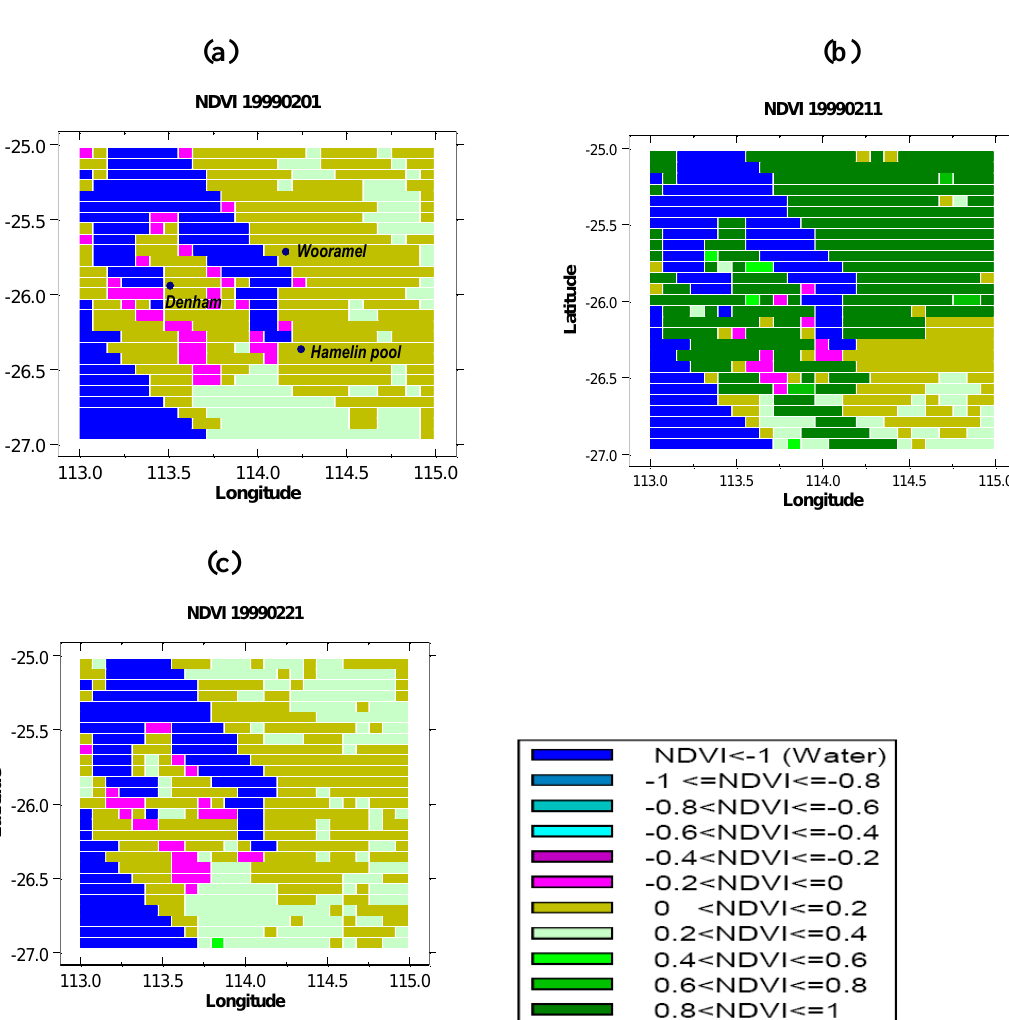
Figure 3. Pathfinder NDVI in 8 km × 8 km resolution (approximately 0.8° Lon × 0.723° Lat) for the first, (a) , second, (b) and last, (c) 10-day composites of February in 1999. The quadrilateral covers longitude range [113°E, 115°E] and latitude [25°S, 27°S]. The city locations shown in the plot (a) are